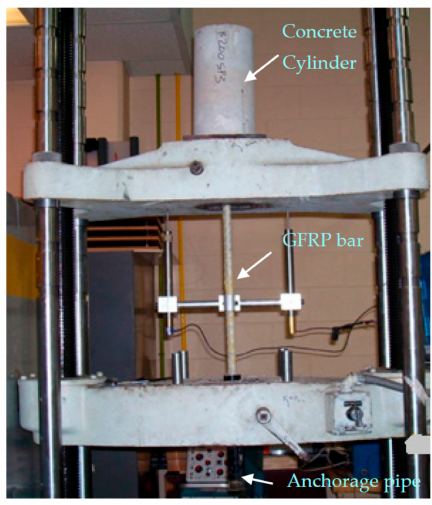
Figure 4. Bond Test set up.